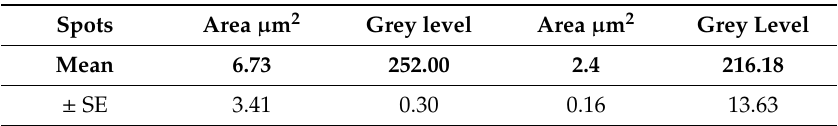
Figure 6. Table 1—Comparative fluorescence intensity of D2 receptor spots evaluated by Java image processing and ImageJ in microphotographs from confocal laser scanning microscopy. D2 positive spots were randomly selected and marked in red in control Tor1a +/+ ( A ), and mutant Tor1a +/ − knock-out ( B ) mice. Bar in B = 2 µ m. Table 1—Results were expressed as the mean + SE of the area and the average grey values (0–255) within the selected spots of the dorsolateral caudate-putamen of both hemispheres from three mice in each group. Marked decrease of the area (see analysis in Figure 5), but not of the grey level in D2 positive spots was observed in mutant Tor1a +/ − knock-out mice, compared with controls. Table 1. Control